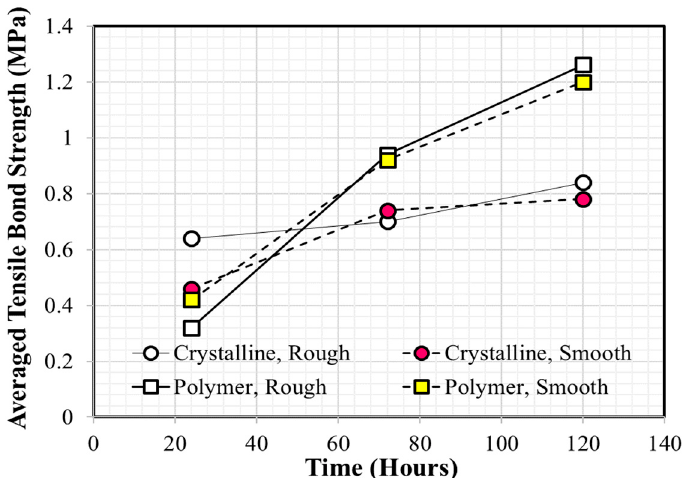
Figure 1. Average tensile bond strength values of crystalline and polymeric coatings (Redrawn using the data of Al-Kheetan et al. [26]).